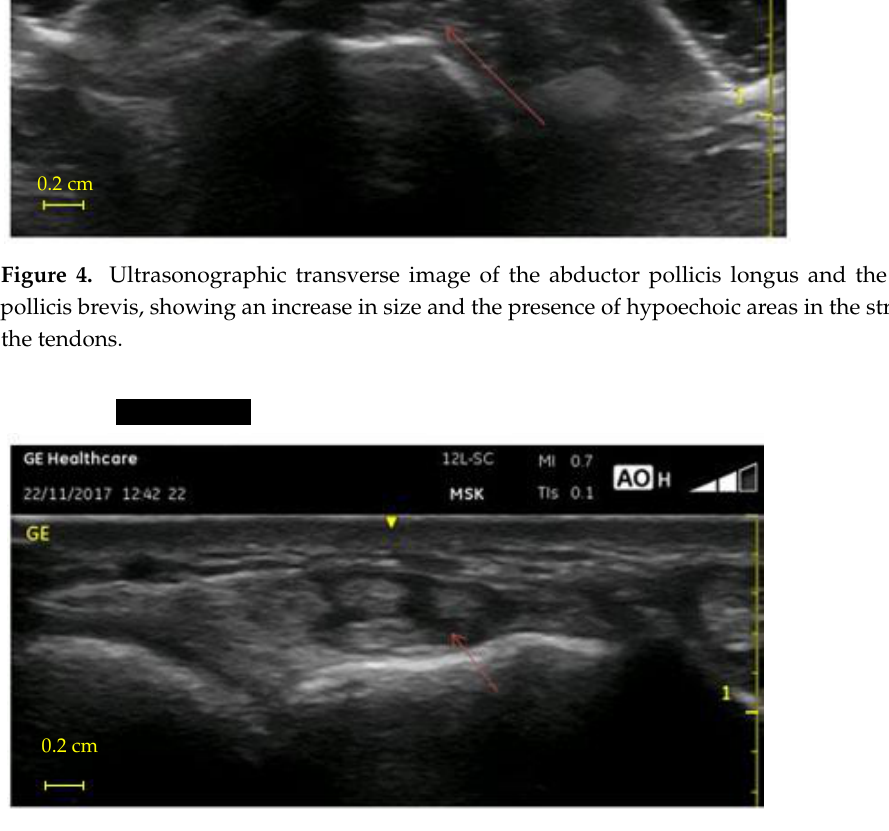
Figure 5. Ultrasonographic transverse image of the extensor digitorum communi tendons, showing a hypoechoic thickening of the synovial sheath.